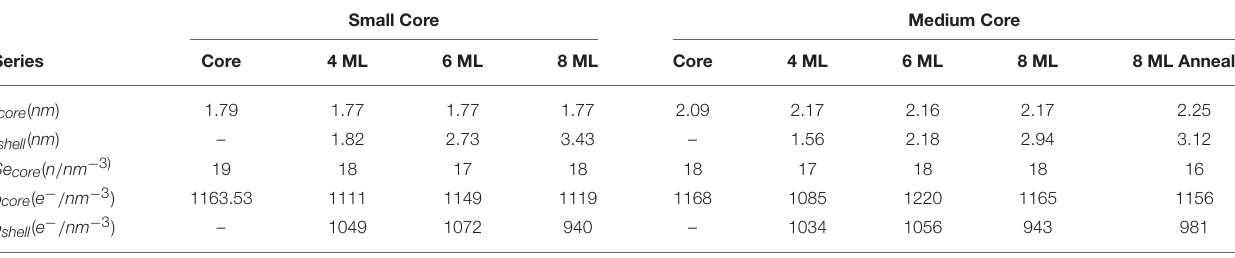
TABLE 1 | Listing of the fitting parameters for the spherical core shell model applied to the small and medium core series. Small